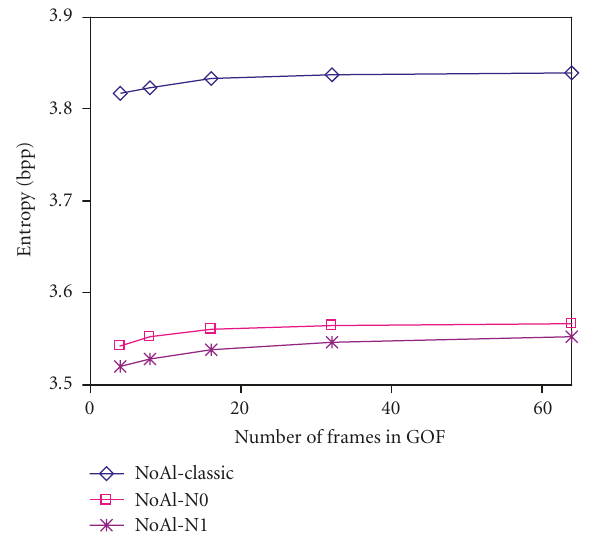
Figure 11: Entropy: 1024 × 1024 pixels per